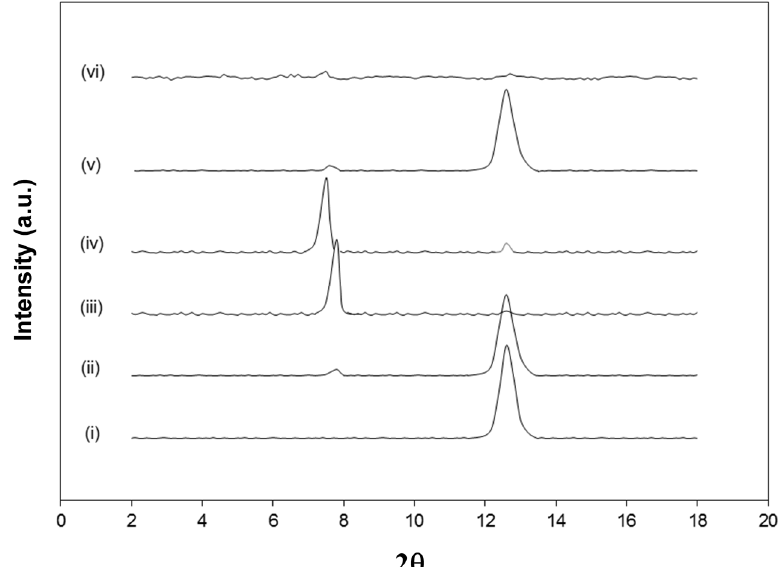
Figure 2. X-ray diffraction (XRD) powder diffraction patterns of ( i ) Kln, ( ii ) Kln/DMSO 20 h, ( iii ) Kln/DMSO + water 10 h, ( iv ) Kln/a-SMA = 70:30, ( v ) Kln/SMI = 70:30 physically mixed ( vi ) Kln/SMI = 70:30 chemically